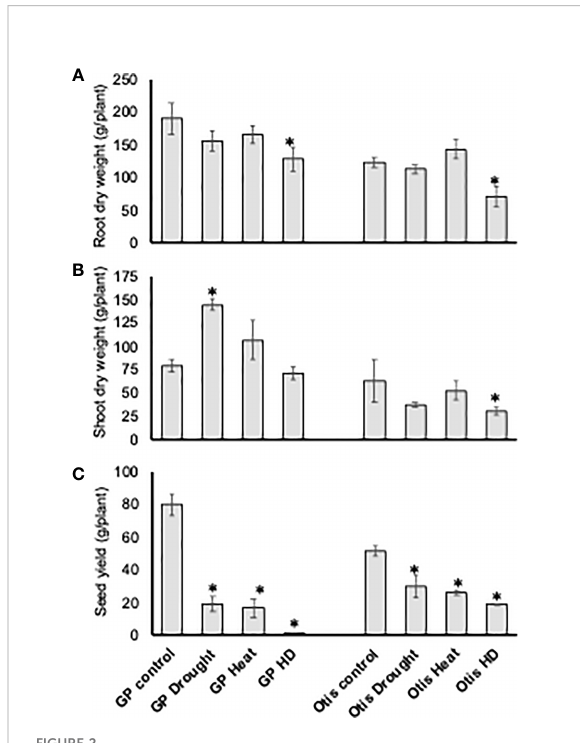
FIGURE 2 Analysis of dry root biomass (A) , shoot biomass (B) , and seed yield (C) in response to heat, drought and combined stress in Golden Promise and Otis. Error bars represent standard deviations of the mean of fi ve observations from fi ve different plants for each treatment (n=5). Statistically signi fi cant differences in measured traits when compared to non-stressed control plants are denoted by ‘ * ’ above the bars (* P -value